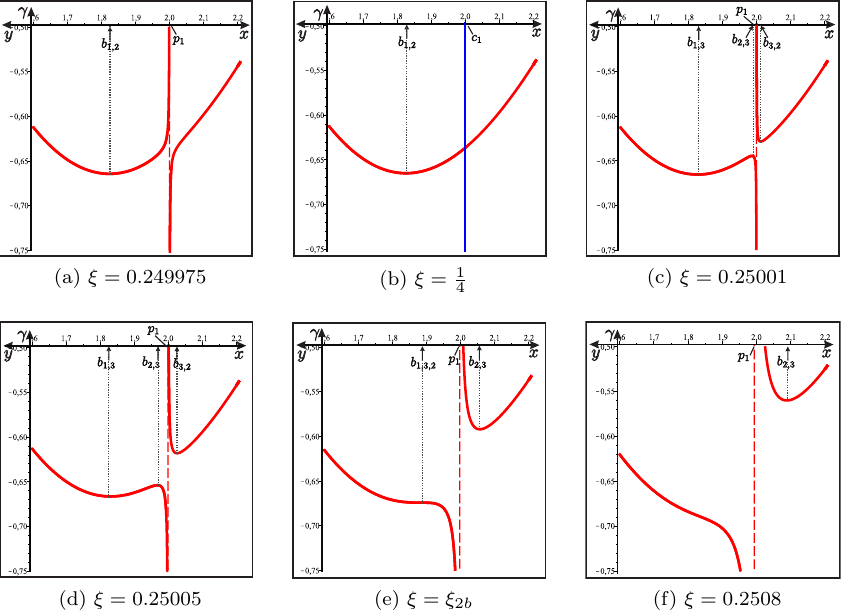
Figure 3. Real CF in the neighborhood CEP x = 2 for ξ = 1 / 4 and in the neighborhood of the second order critical point for ξ = ξ 2 b ≈ 0 .